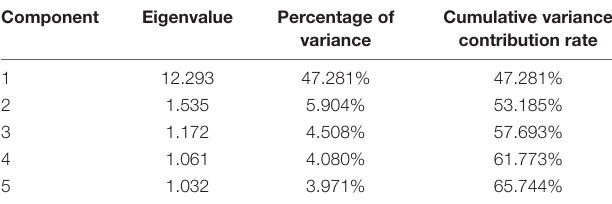
TABLE 3 | The eigenvalues and contribution rates of the five factors in the